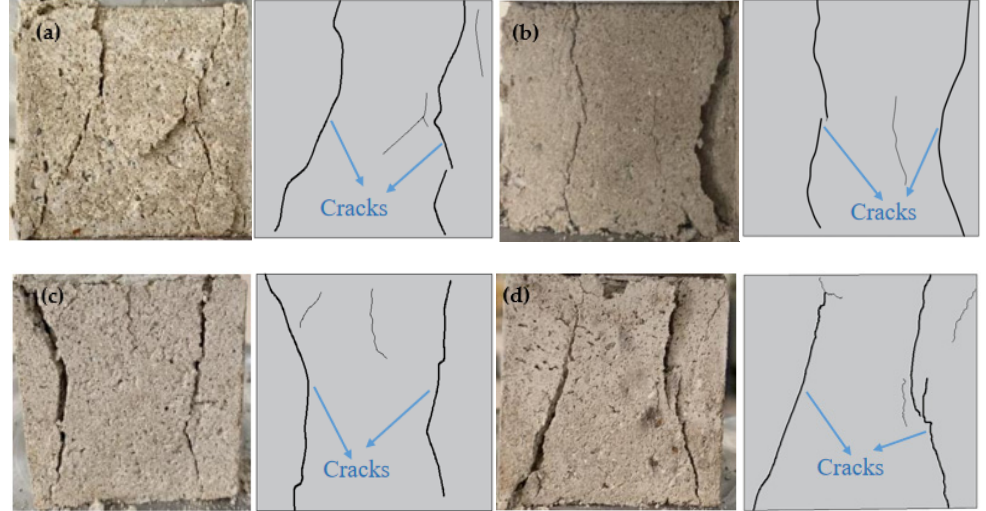
Figure 8. Failure modes of the gray brick under different curing methods. ( a ) Natural curing; ( b ) autoclave curing; ( c ) carbon dioxide curing; ( d ) autoclave–carbon dioxide curing.